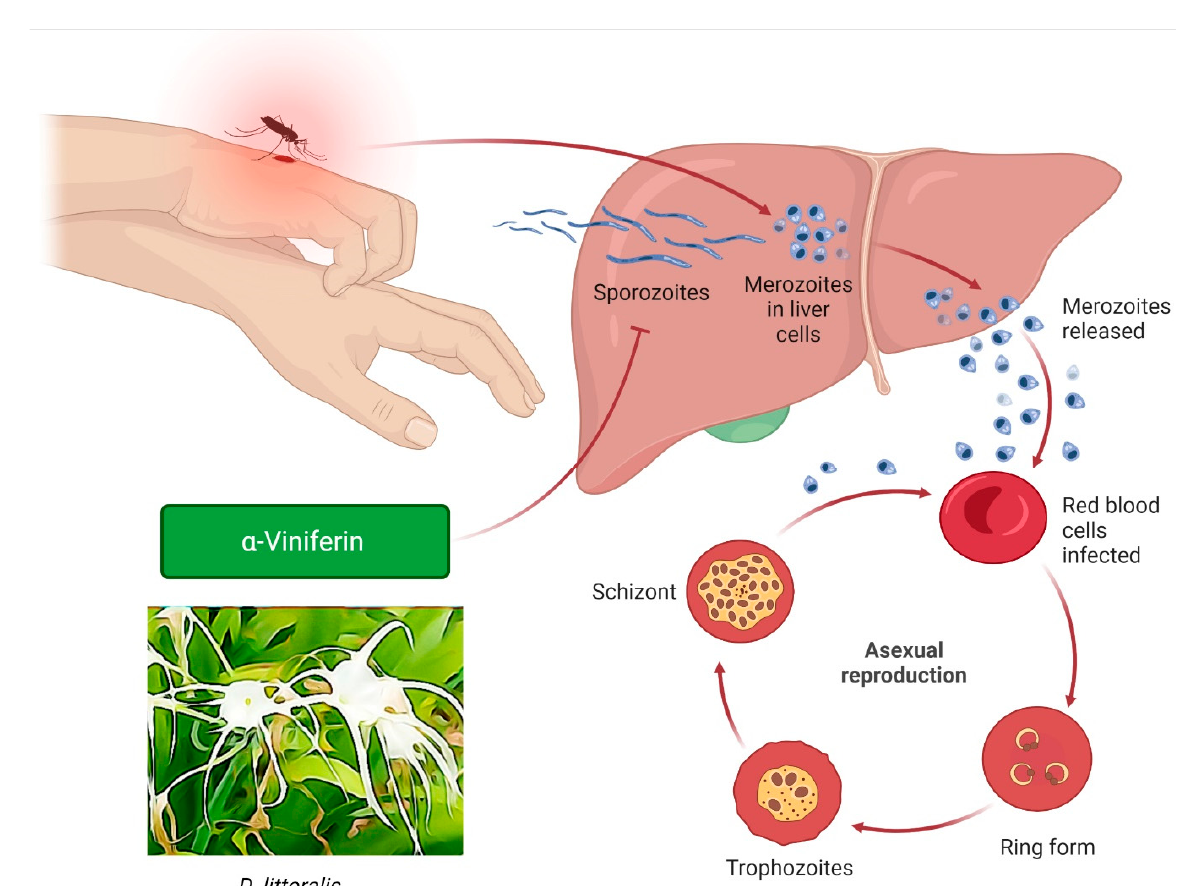
Figure 6. The bite of a female Anopheles mosquito carrying the plasmodium parasite transmits malaria to humans. When Sporozoites are injected into the bloodstream, they travel to the hepatocytes of the liver, where they mature into schizonts that rupture and release merozoites. Merozoites invade erythrocytes in order to multiply asexually. It was found that α -viniferin inhibited plasmodium in vitro; consequently, it has the potential to be exploited and enhanced for the control of plasmodium.